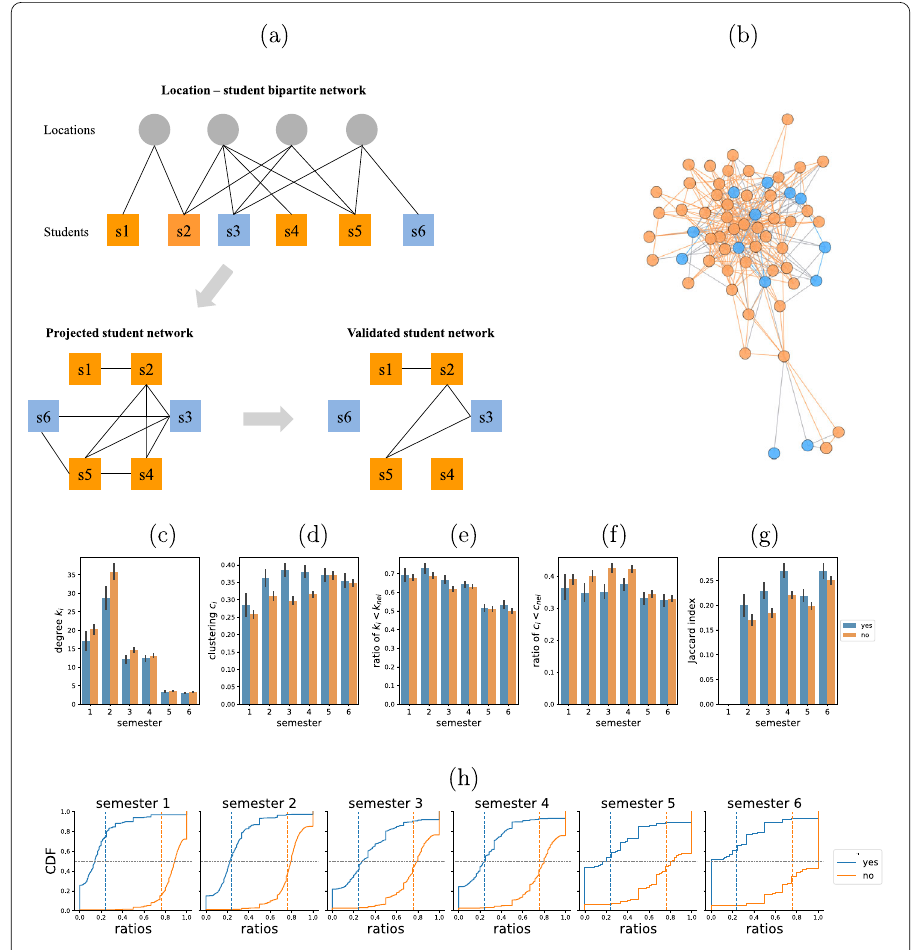
Figure 2 Co-location social network structures between students who failed and those who did not. ( a ) Network modeling procedure. ( b ) An example of inferred students network. For visualization, only one student with her/his neighbors are shown in the graph. Failed students are in blue and non-failed students are in orange. Edges in orange and blue indicate homogeneous connections and those in grey indicate heterogeneous connections. ( c )–( g ) The heights of bars represent the average levels for these indicators. Error bars (black) show the 95 percent confidence intervals of mean estimation. Jaccard index of a student in X is defined as the number of overlapping edges of his ego-network between two consecutive semesters divided by the average of number of edges in these two semesters, which measures the stability of a student’s connections in different snapshots of campus network. ( h ) The blue line shows the CDF of ratio yes . The orange line shows the CDF of ratio no . The dashed lines are benchmark ratios. The blue dashed line is ratio yes – baseline . and the orange one is ratio no – baseline . The horizontal grey dashed line is where the CDF is equal to